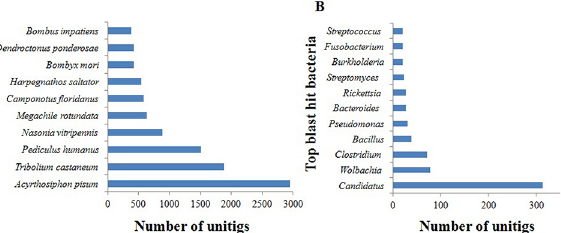
Fig 2. Top blast hit species distribution at NCBI-nr protein database. Top ten blasts hit insect (A) and bacterial (B) species with whitefly unitigs in the NCBI nr protein